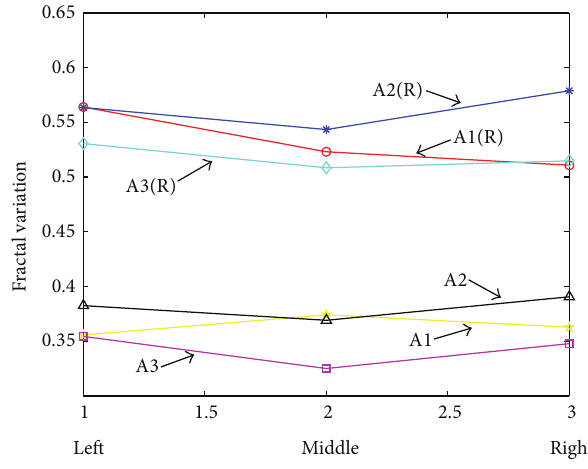
Figure 13: The mean snr of rock specimens under loading speed A, B, C.